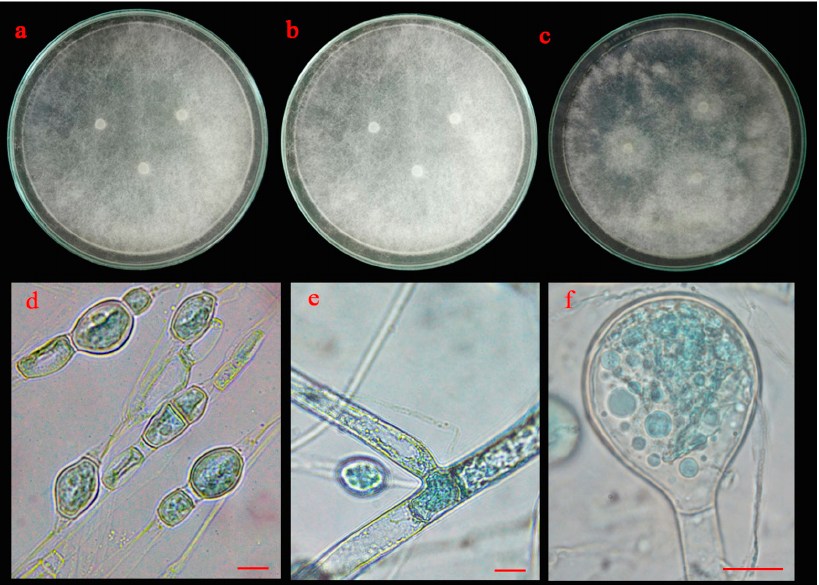
Fig. 5.(C). Morphological characteristics of SR02 isolate: colonies of SR02 isolate on three different media (a; PDA, b; MEA and c; CYA medium); chlamydospores (d), sporangiophore with lake of rhizoid (e) and sporangia and sporangiospore (f); the scale bar = 10 µm.